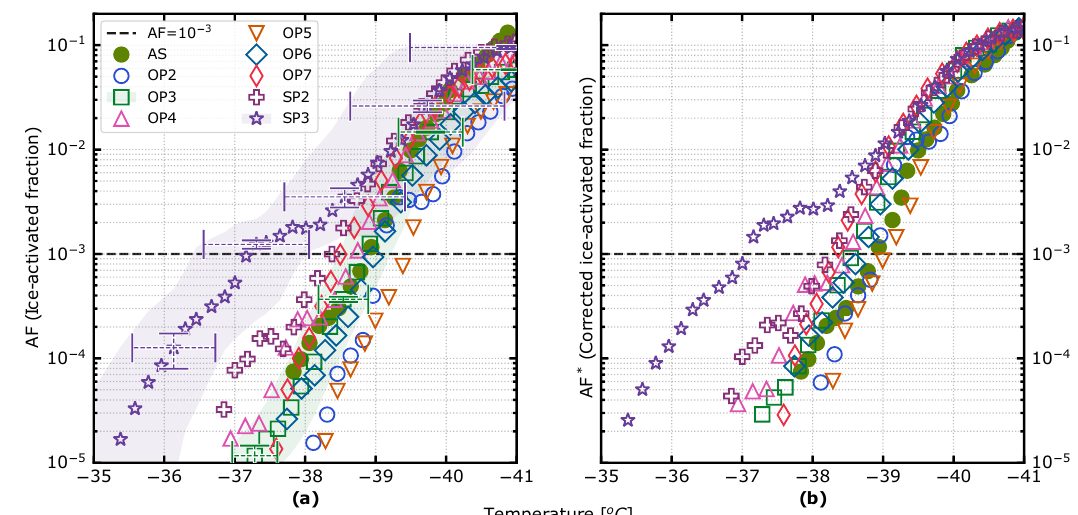
Figure 3. ( a ) Ice-activated fraction ( AF ) as a function of temperature for each setpoint sample, as detected by the SPIN. Uncertainties are presented for the OP3 and SP3 cases as one standard deviation in each dimension. ( b ) Corrected ice- activated fraction ( AF ∗ ) as a function of temperature for each setpoint sample, where low-biased samples are normalised with respect to the ammonium sulfate homogeneous freezing reference (denoted AS in the legend) for the lowest temperatures at which all droplets are assumed to have been frozen. The dashed line denotes the AF = 10 − 3 threshold for which T onset was